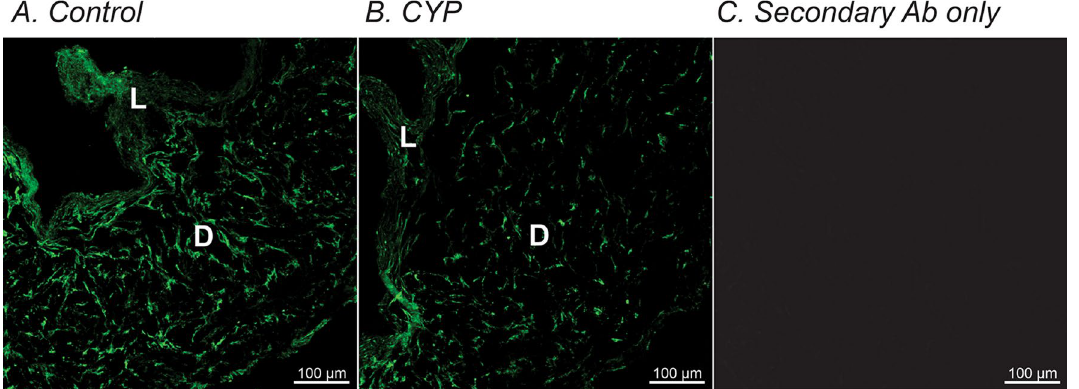
Figure 2. Immunohistochemistry of PDGFRα in murine detrusor from control and CYP-treated bladders. ( A ) Whole mount detrusor with PDGFRα staining (green) from saline-treated control mouse. ( B ) Immunoreactivity with PDGFRα (green) antibody was decreased in CYP-treated bladder detrusor compared with control ( A ). ( C ) Secondary antibody only (no primary antibody control) produce little to no visual background. L and D denote lamina propria and detrusor muscle, respectively.